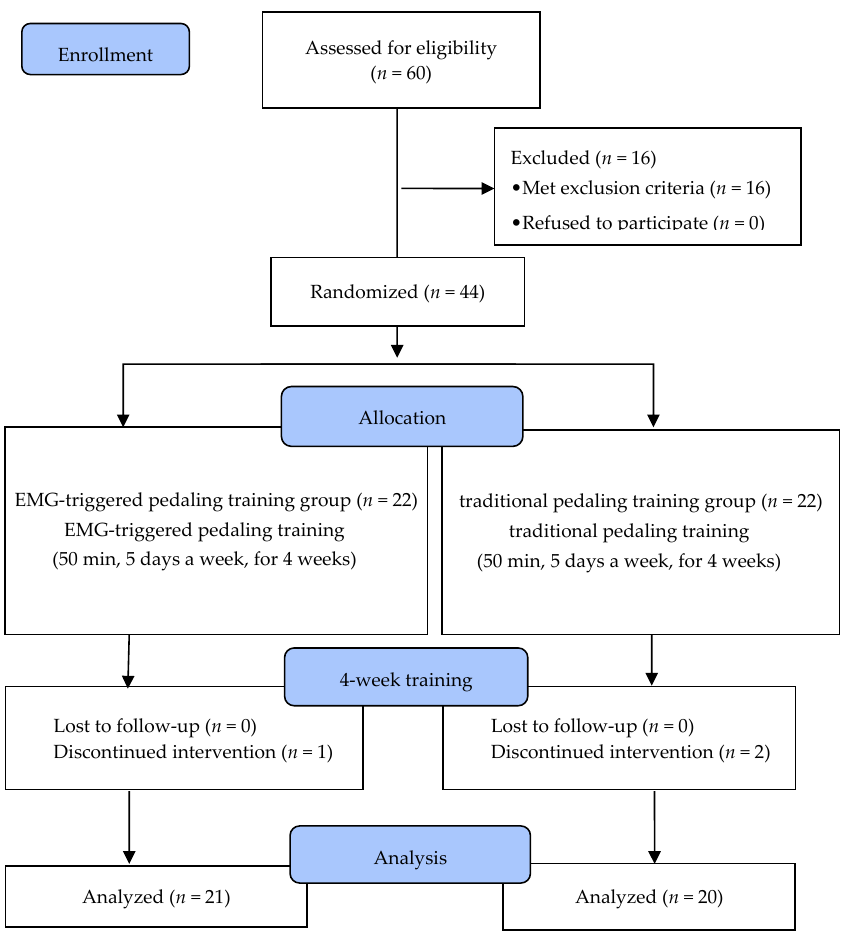
Figure 1. Flow diagram of the study. EMG, Electromyography.